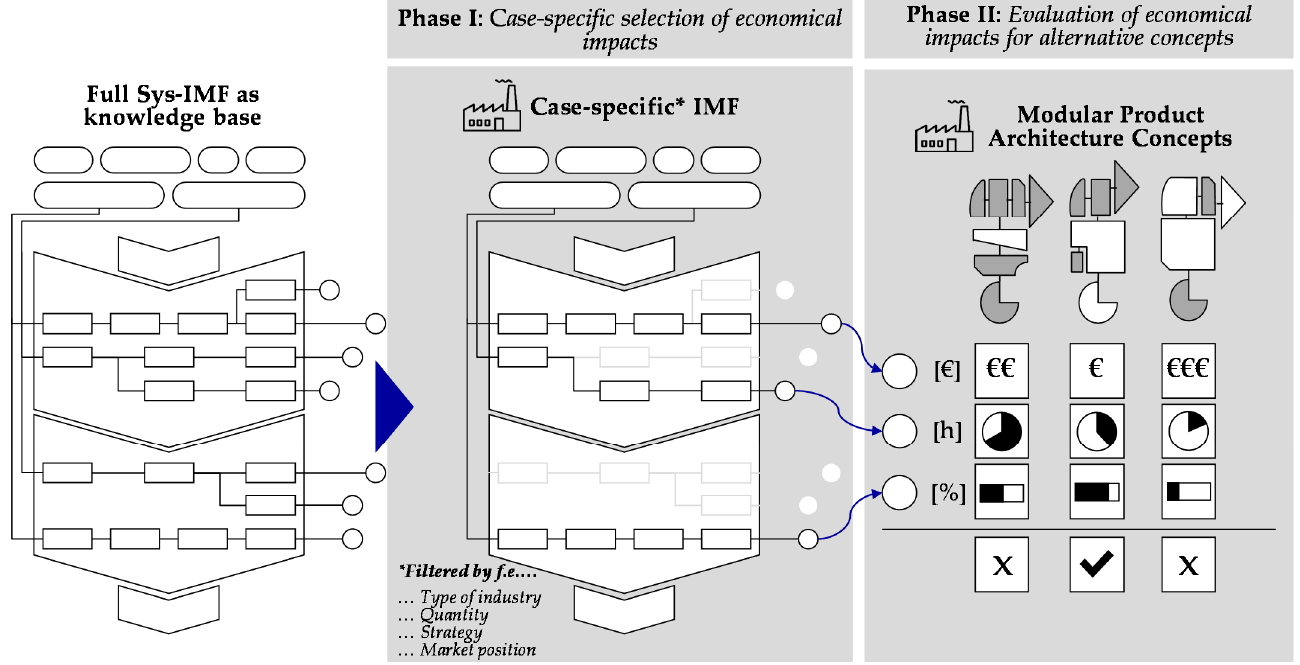
Figure 10. Illustration of the approach to support the evaluation of alternative modular product architecture concepts.